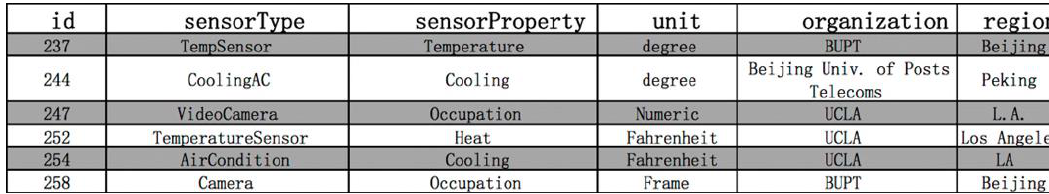
Figure 14. A snapshot of the AG table containing devices with five columns and corresponding row cell texts.